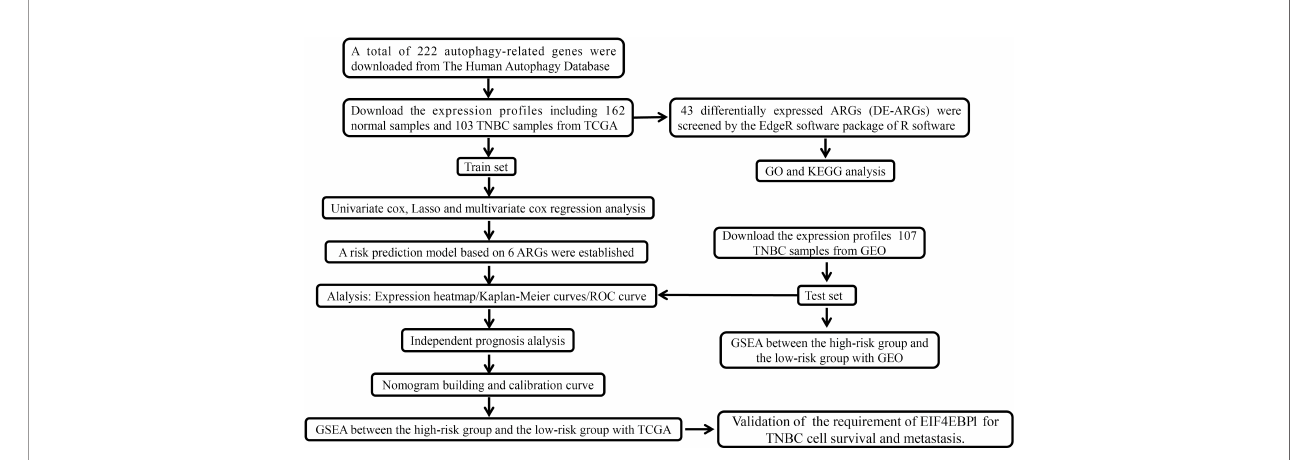
FIGURE 1 | The fl owchart describing the experimental design to establish and validate the prognostic signature in